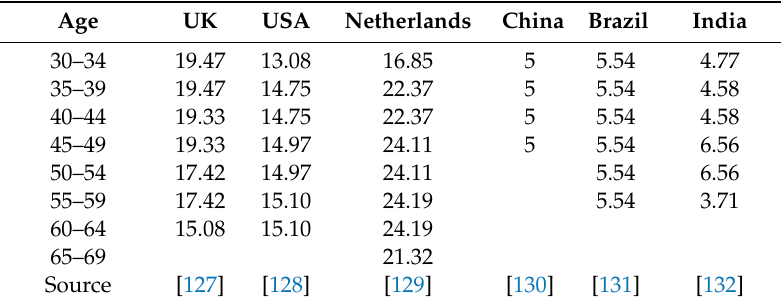
Table A3. Hourly wage rage across countries (USA dollars in 2016). Age UK USA Netherlands